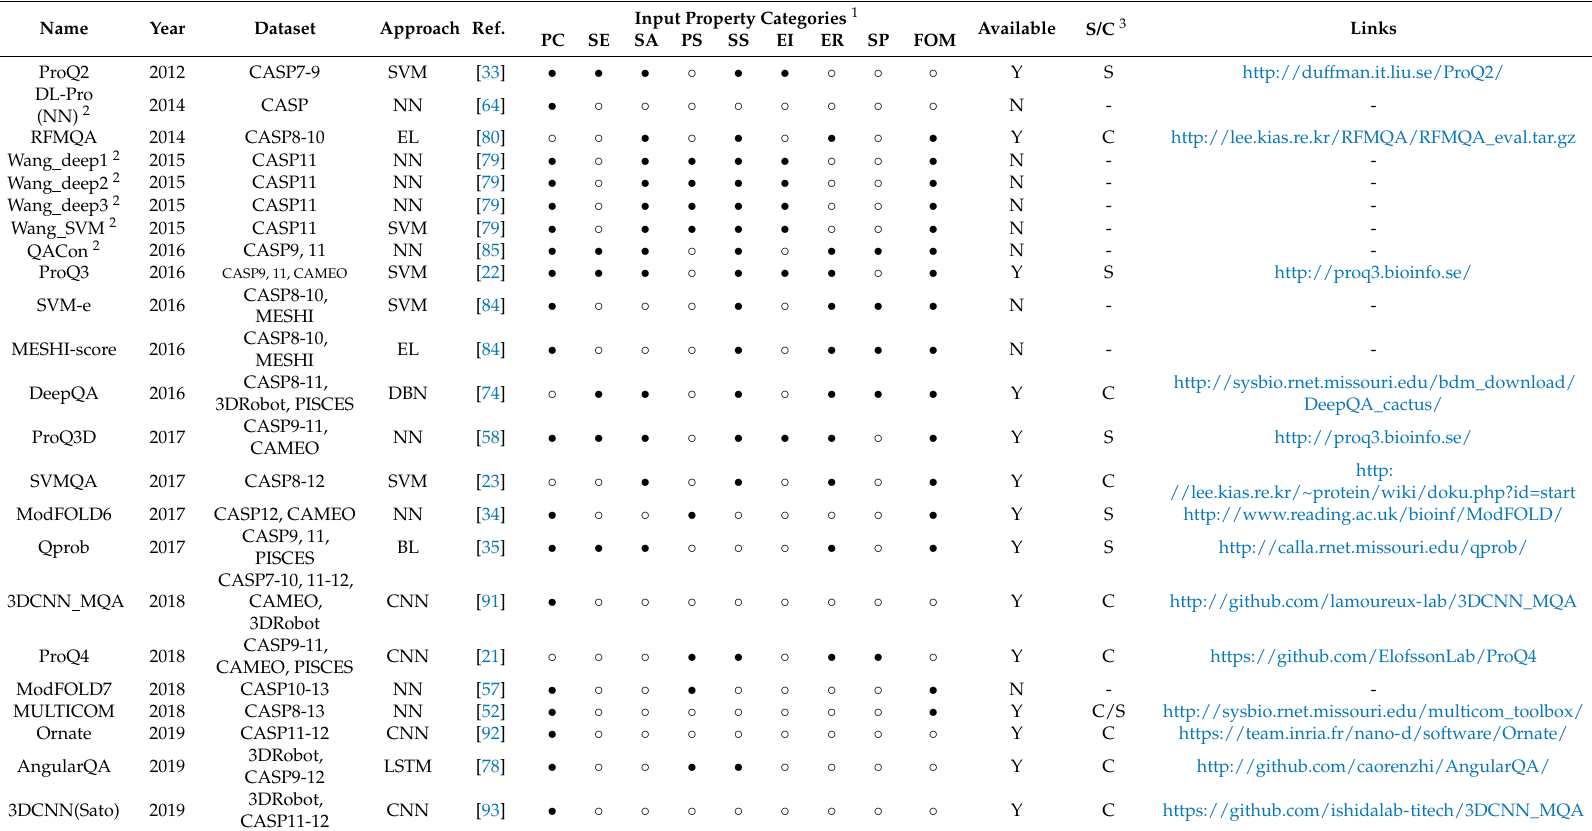
Table 4. Comparison of different EMA